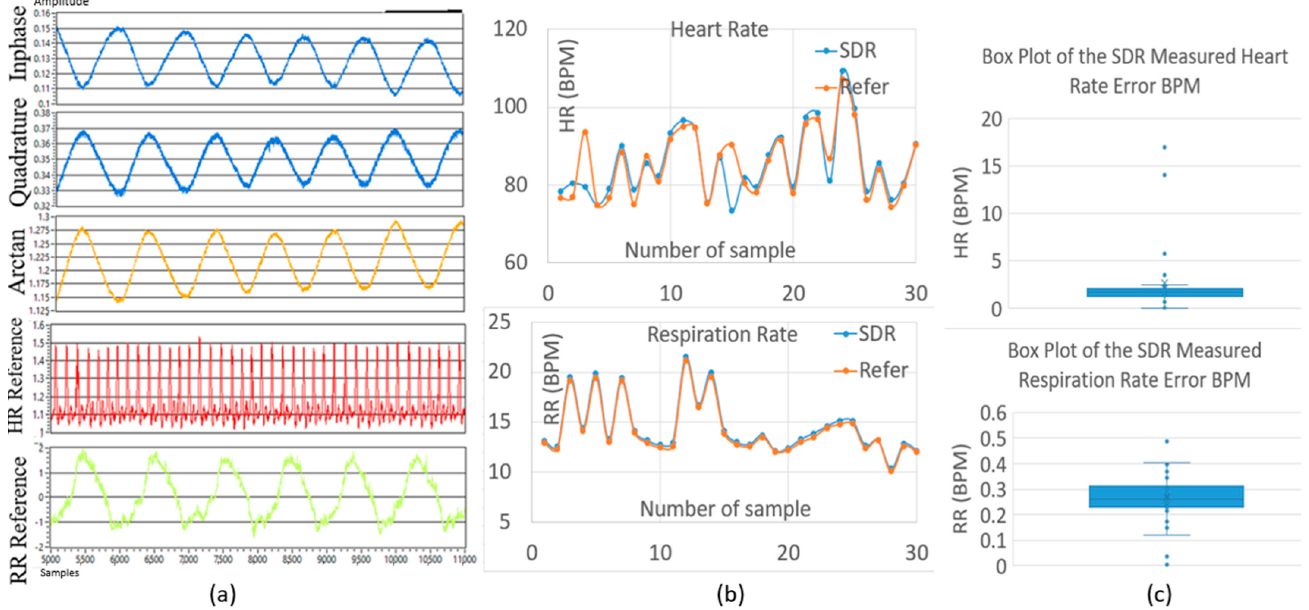
Figure 5. Example of output waveforms and test data and errors from the NCVS monitoring of 30 test cases gathered from 7 student volunteers with optimized NCVS system settings at our engineering lab: ( a ) measured I/Q/Arctan waveforms with reference HR/RR signals; ( b ) NCVS − measured HR/RR data vs. reference sensor data; ( c ) HR/RR errors in boxplots vs. reference signals.